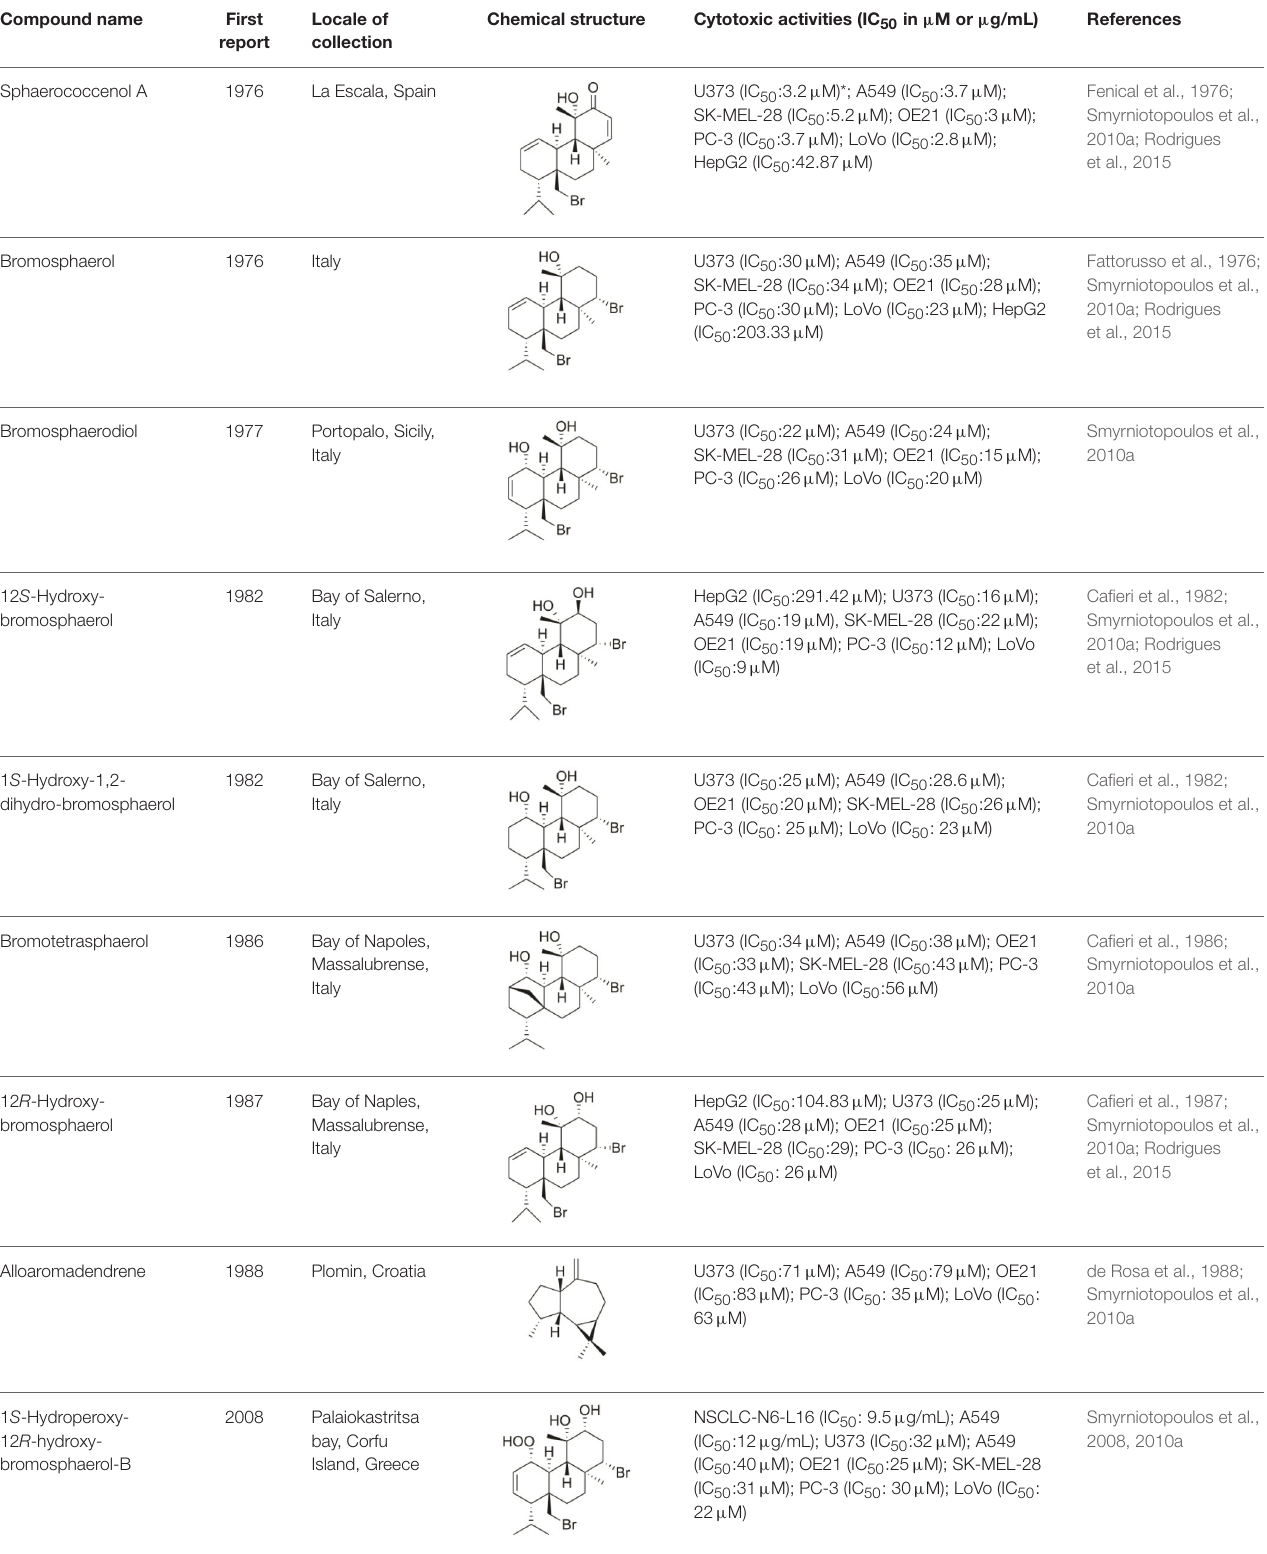
TABLE 2 | Cytotoxic compounds isolated from Sphaerococcus coronopifolius